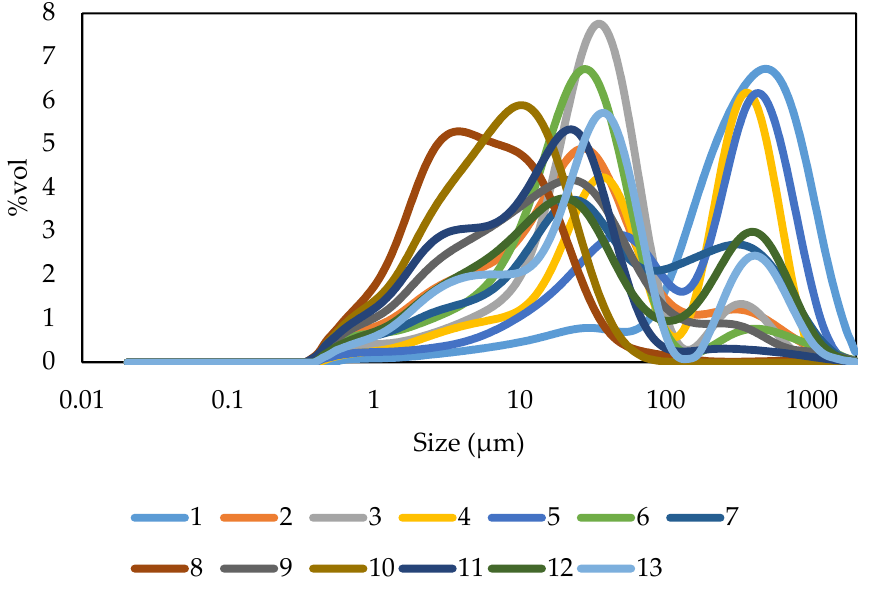
Figure 2. Samples PSD obtained by LDM.